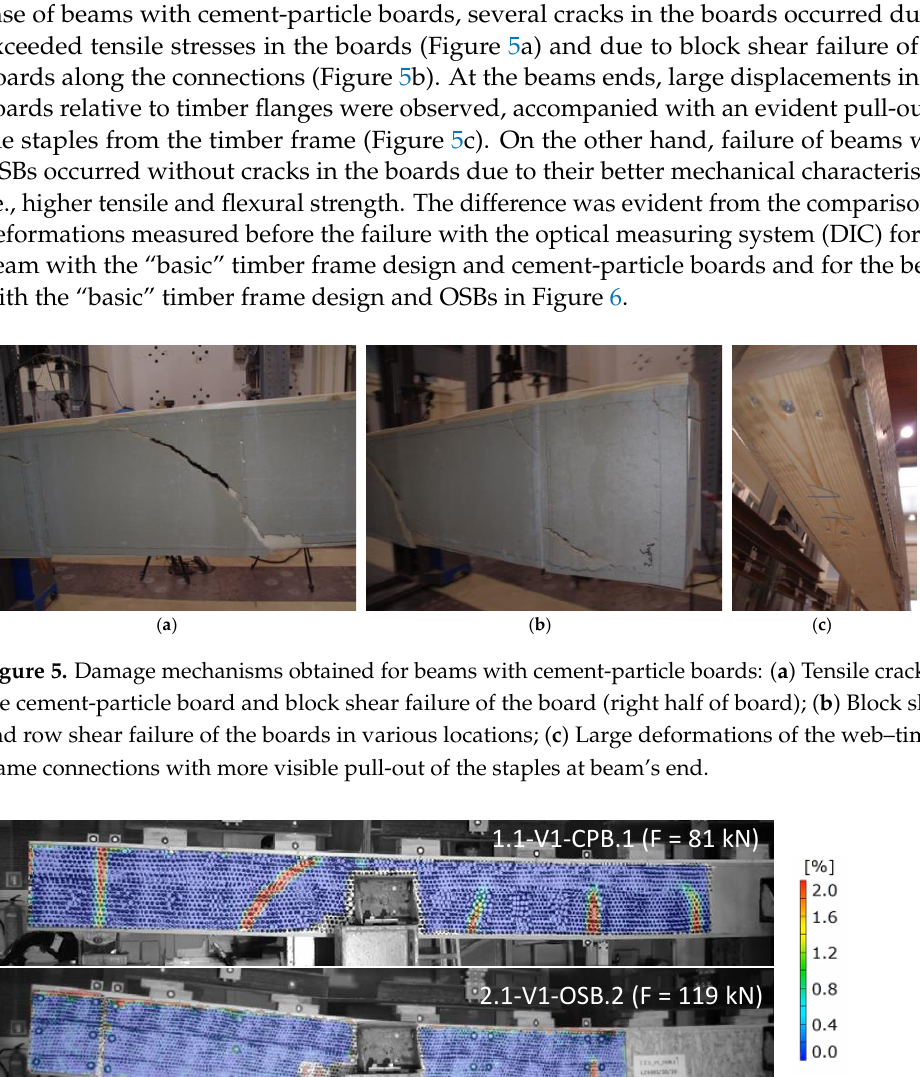
Figure 6. Deformations measured in the boards with optical measuring system before the beams’ failure for beam without diagonals with cement-particle boards ( top ) or with OSBs ( bottom ). For both beams with cement-particle boards and with OSBs, the beams collapsed due to failure of the bottom flange. The final failure of the beam with cement-particle boards